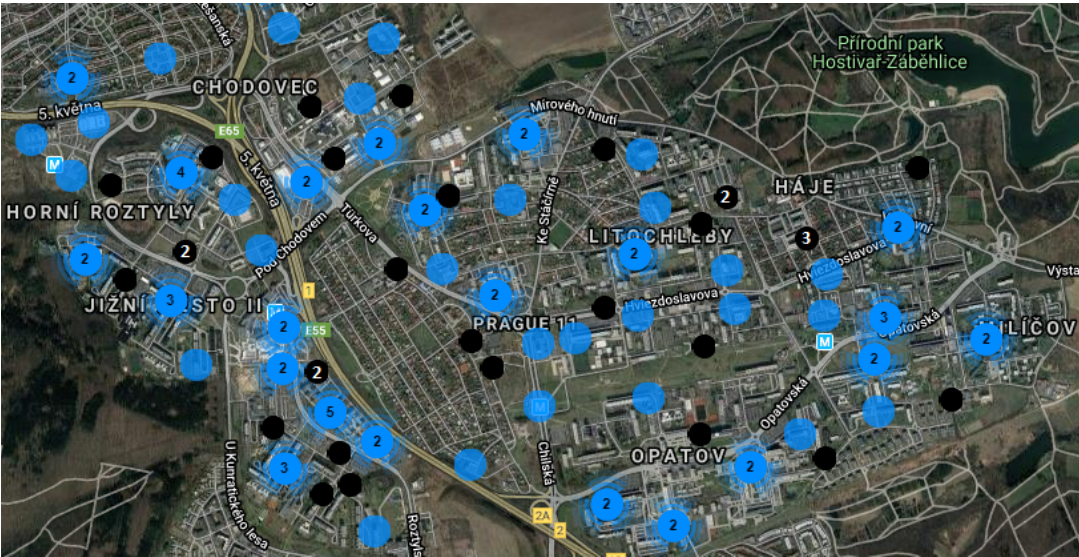
Figure 8. Selected gNodeB deployment with the new requirements, the numbers in the circles indicate the number of gNodeB nodes in the particular